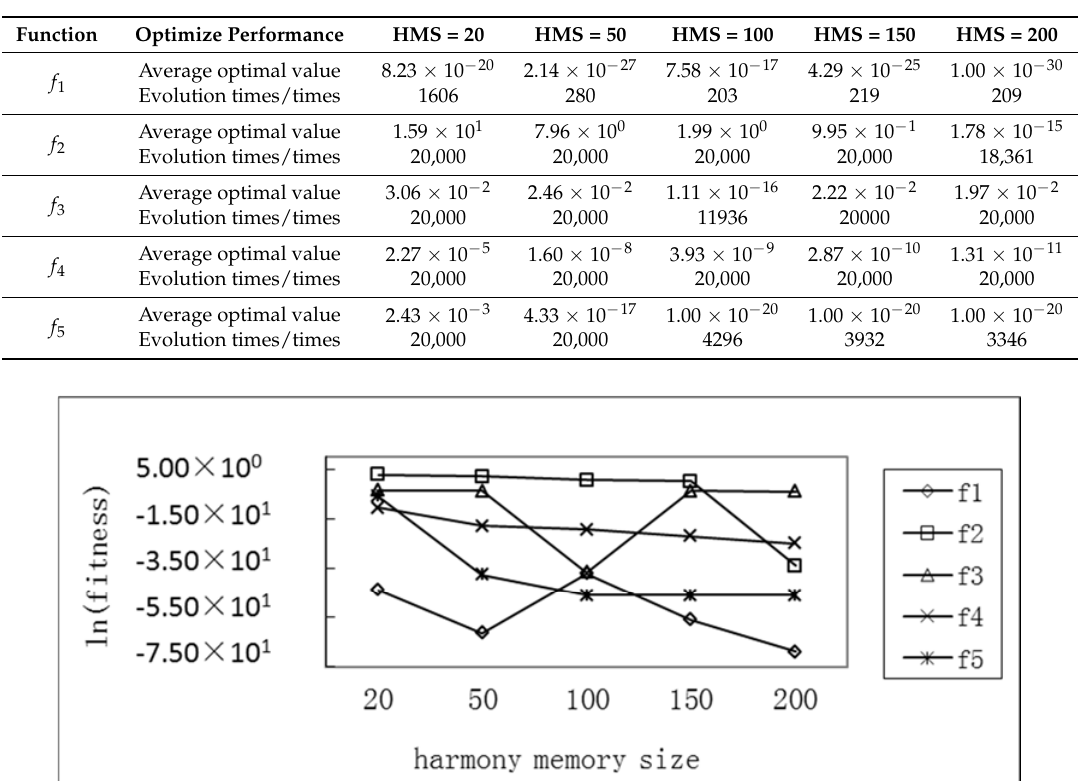
Figure 13. Comparison of the average optimum with different harmony memory sizes of five functions.